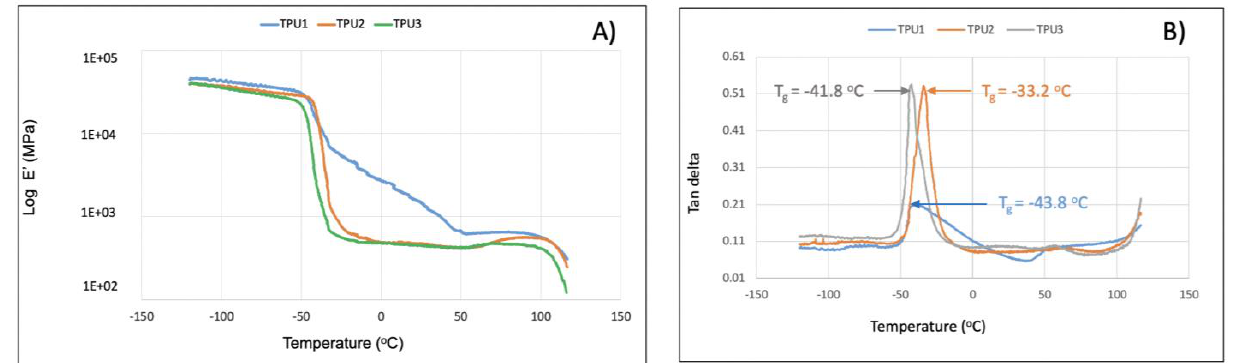
Figure 8. The storage modulus (E’) ( A ) and tangent delta (tan δ ) ( B ) as a function of temperature for Figure 8. T he storage modulus (E’) ( A ) and tangent delta (tan  ) ( B ) as a function of temperature for TPUs determined by DMA TPUs determined by DMA analysis.